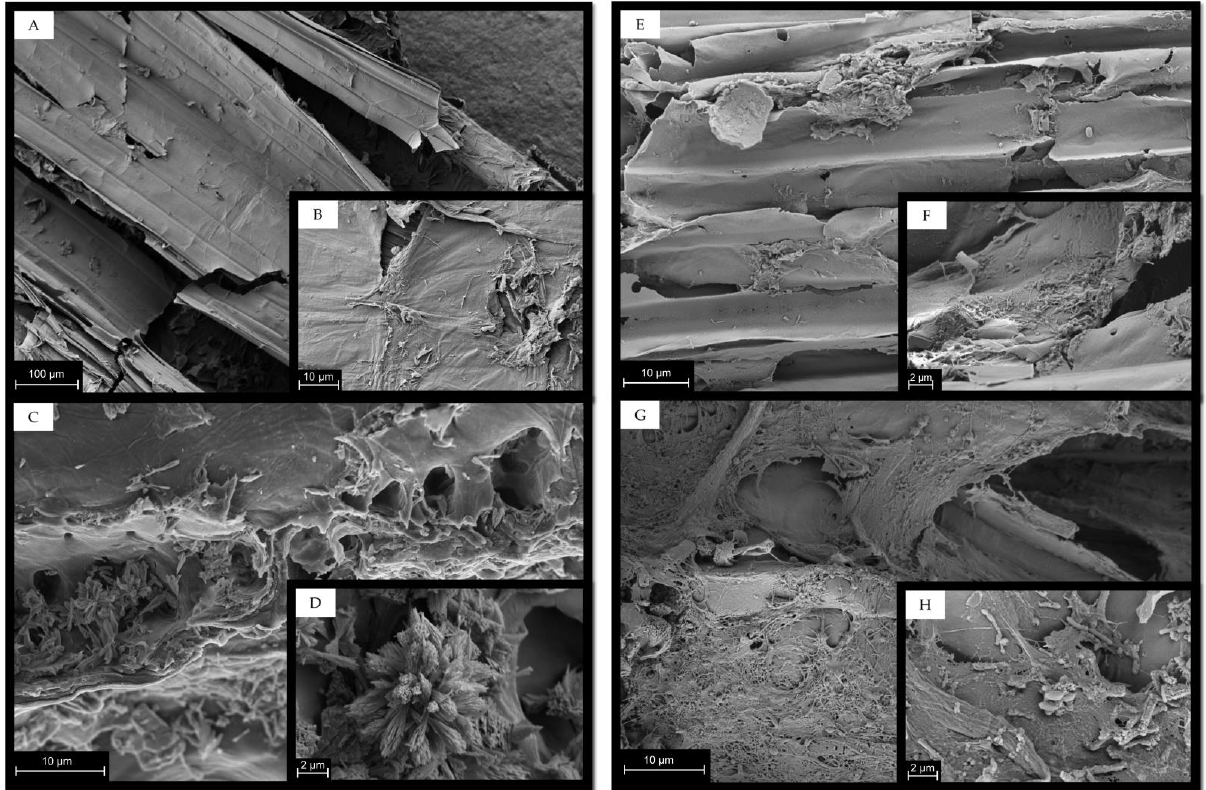
Figure 3. Scanning electron microscopy images of the wheat straw after 45 days of anaerobic digestion, negative control cultures (NC), and hindgut cultures (H). ( A ) NC_1mm_NT—100 µ m zoom in, non treated wheat straw; ( B ) NC_1mm_NT—10 µ m zoom in, detailed non treated wheat straw; ( C ) NC_1mm_T—10 µ m zoom in, crystal-like structures; ( D ) NC_1mm_T—2 µ m zoom in, detailed crystal-like structures; ( E ) H_1mm_NT—10 µ m zoom in, wheat straw without alkaline pretreatment in hindgut culture; ( F ) H_1mm_NT—5 µ m zoom in, detailed wheat straw without alkaline pretreatment in hindgut culture; ( G ) H_1mm_T—10 µ m zoom in, EPS network; ( H ) H_1mm_T—2 µ m zoom in, detailed EPS network and